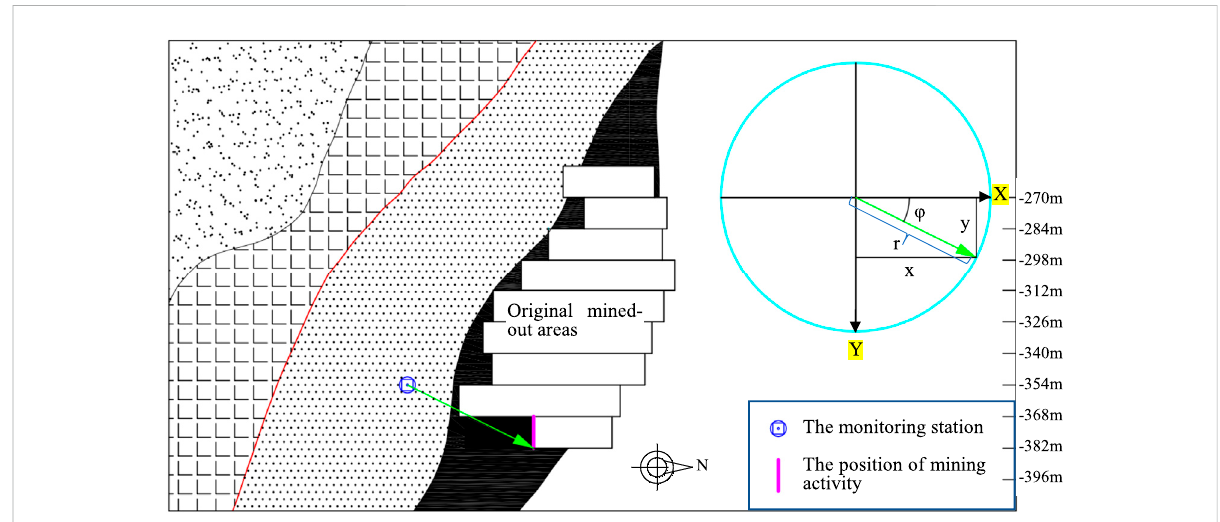
FIGURE 7 Relative position relationship between the monitoring station and the mining activity (section of exploration line